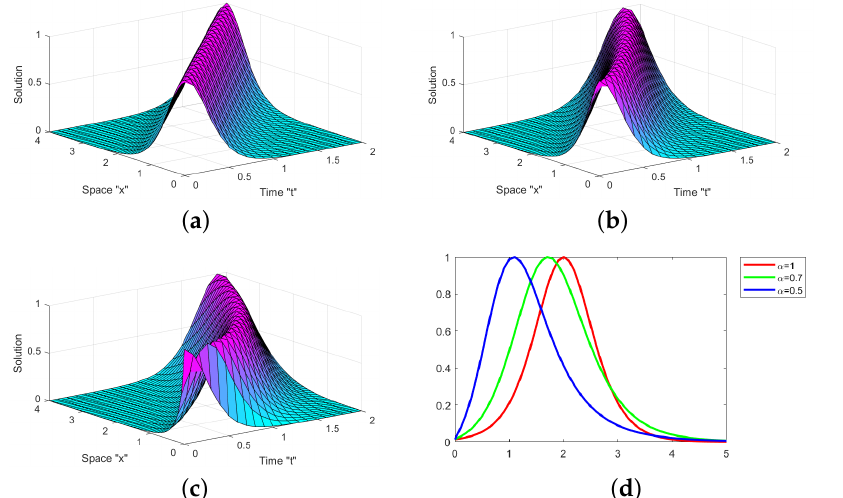
Figure 5. For Equation (26), ( a – c ) indicate the 3D profiles with σ = 0, ( d ) denotes the 2D plot for different values of α at t = 1, and the curves of the solution move to the left. ( a ) α = 1, β = 0, ( b ) α = 0.7, β = 0.9, and ( c ) α = 0.5, β =